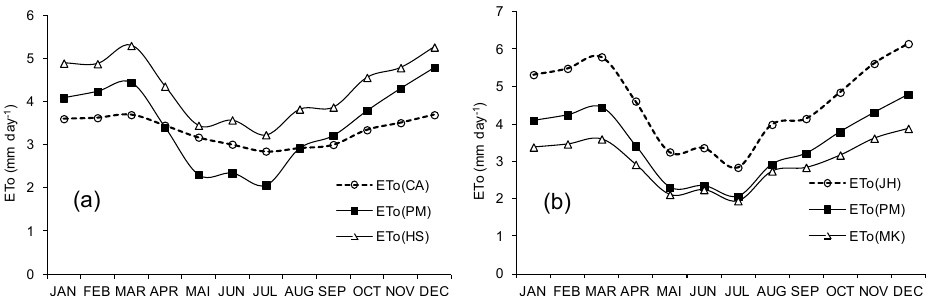
Fig. 7 (a) Comparison of mean monthly ETo calculated from the FAO PM model and the temperature- based methods in São João, Pernambuco, Brazil, during the 2011 growing season. (b) Comparison of mean monthly ETo calculated from the FAO PM model and the radiation-based methods in São João, Pernambuco, Brazil, during the 2011 growing season. (CA), Carmargo; (PM), Penman-Monteith; (HS), Hargreaves-Samani; (JH), Jensen-Haise; (MK),